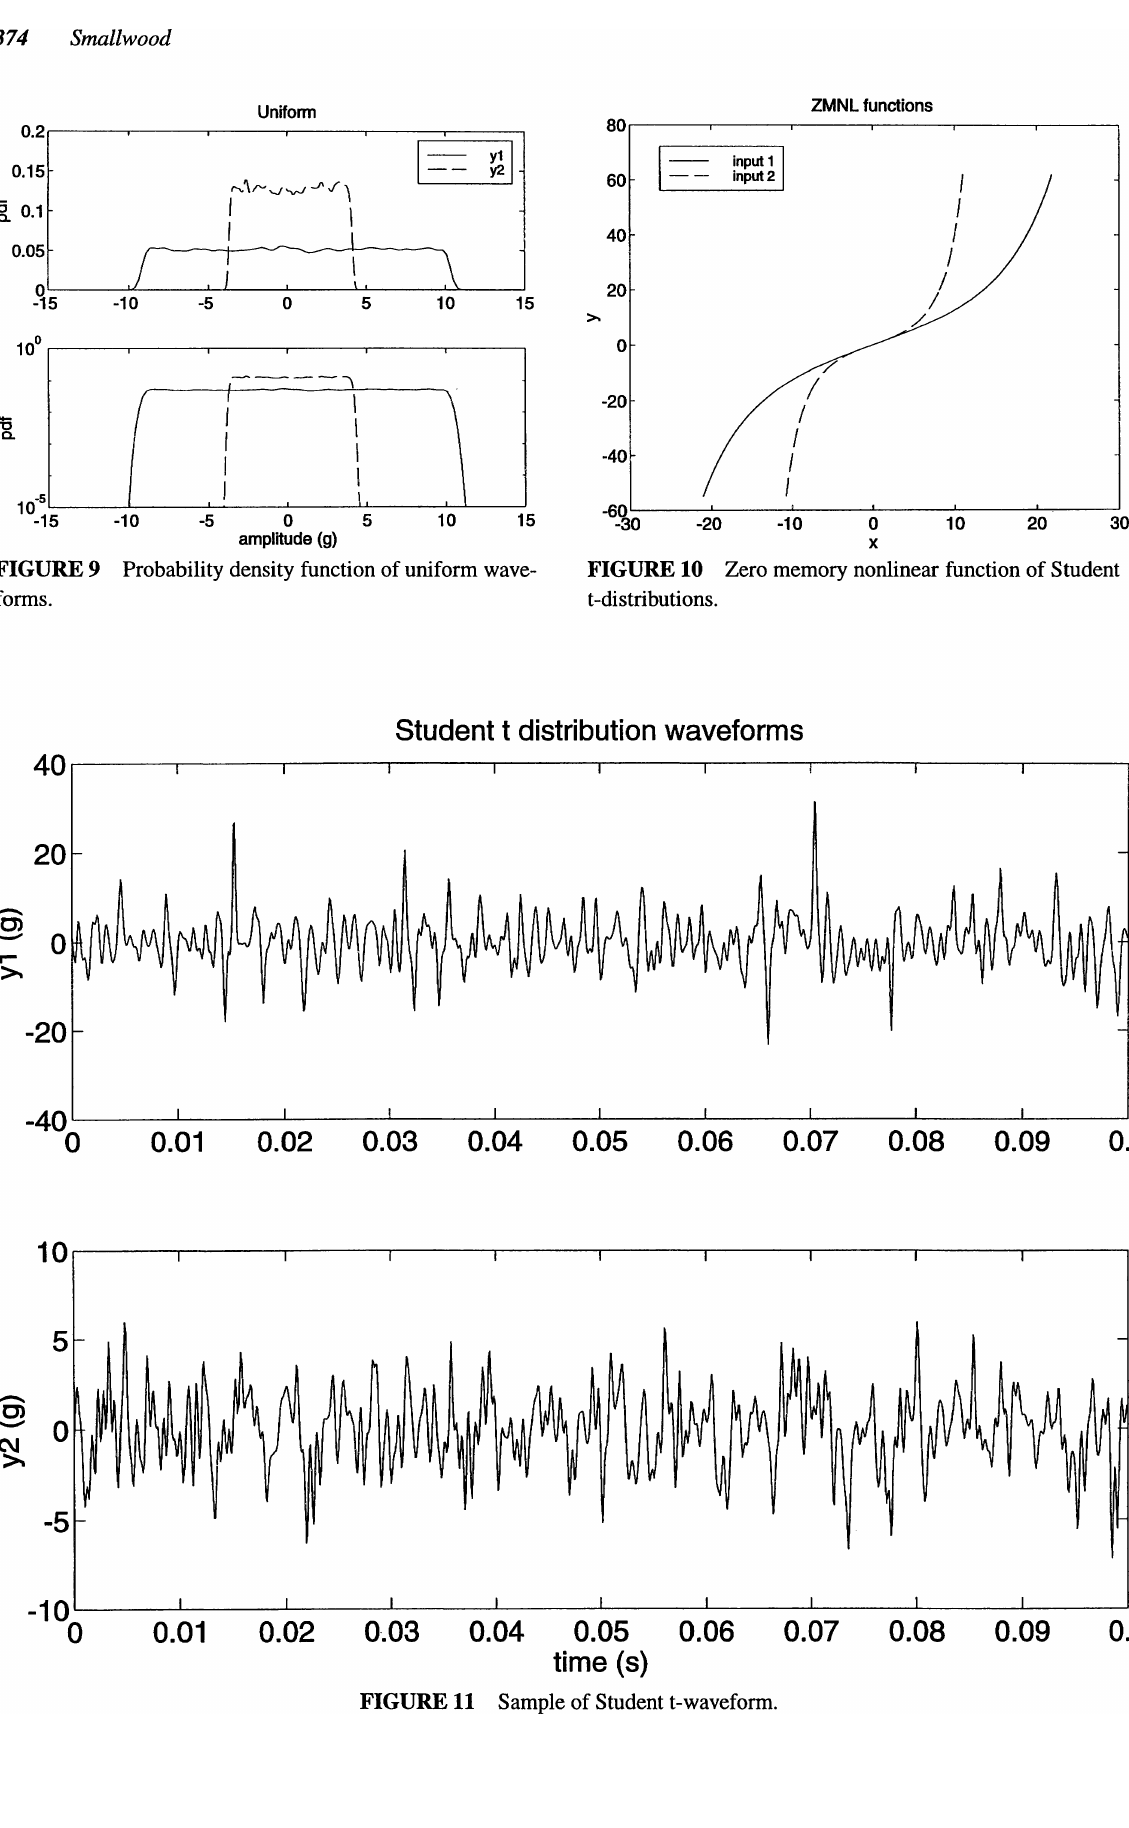
FIGURE 11 Sample of Student